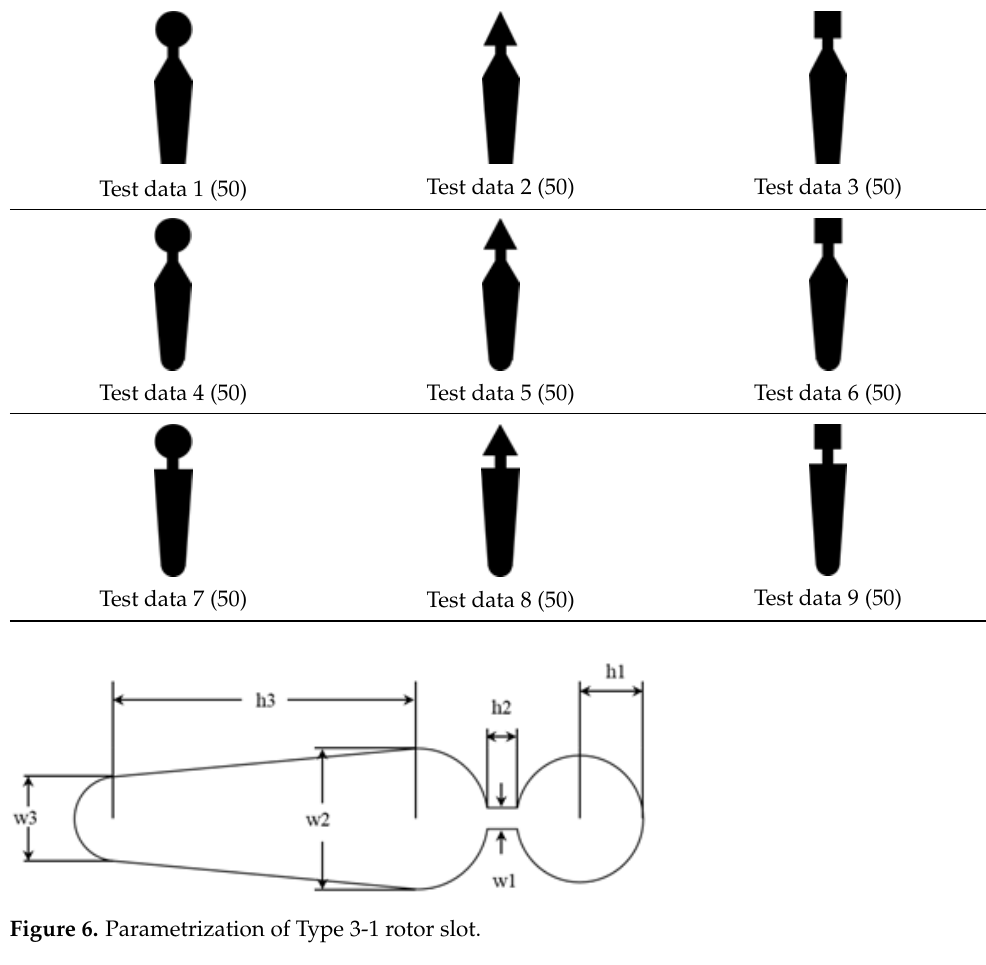
Table 4. Example shapes of the rotor slot for test data.